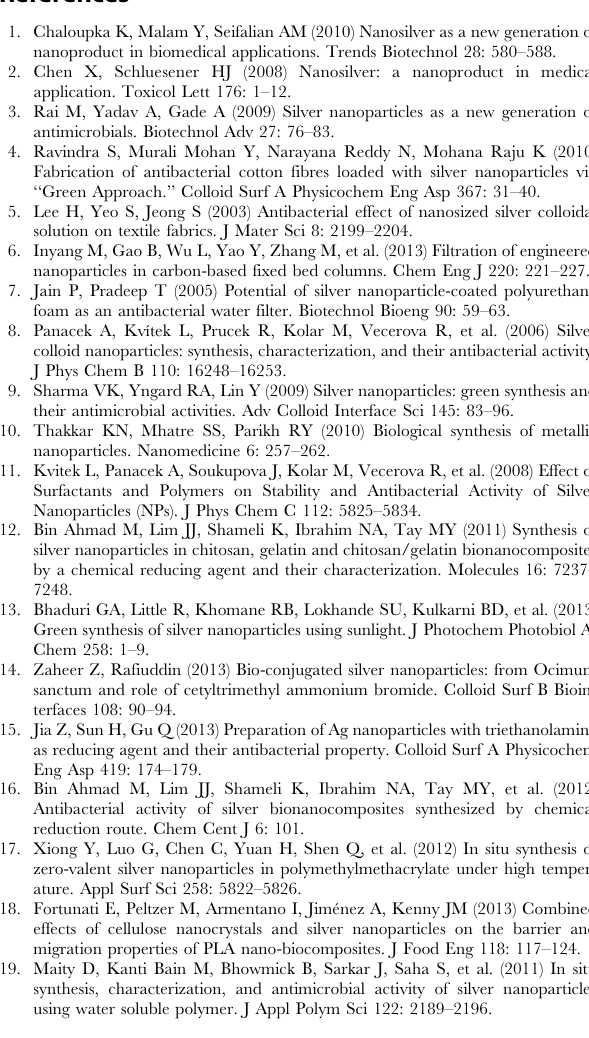
Figure S4 Evaluation of the CCC value from UV/vis spectra using titration with a PDDA solution. (DOC) Table S1 Minimum inhibitory concentrations [mg ? L 2 1 ] of AgNPs reduced by maltose, ascorbic acid, or sodium borohydride in systems influenced/modified by gelatin at a concentration of 0.05%